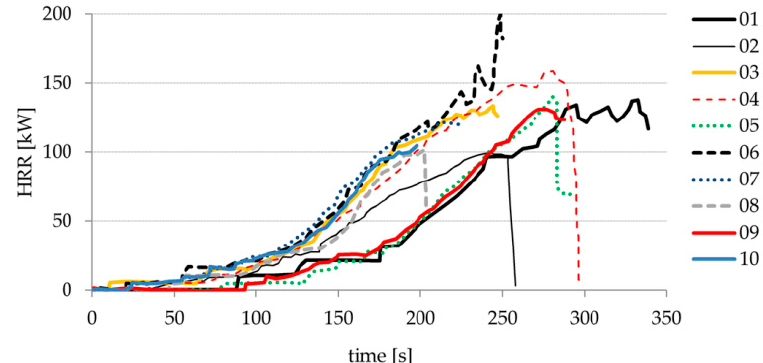
Figure 7. HRR curves for experiments 01–10.